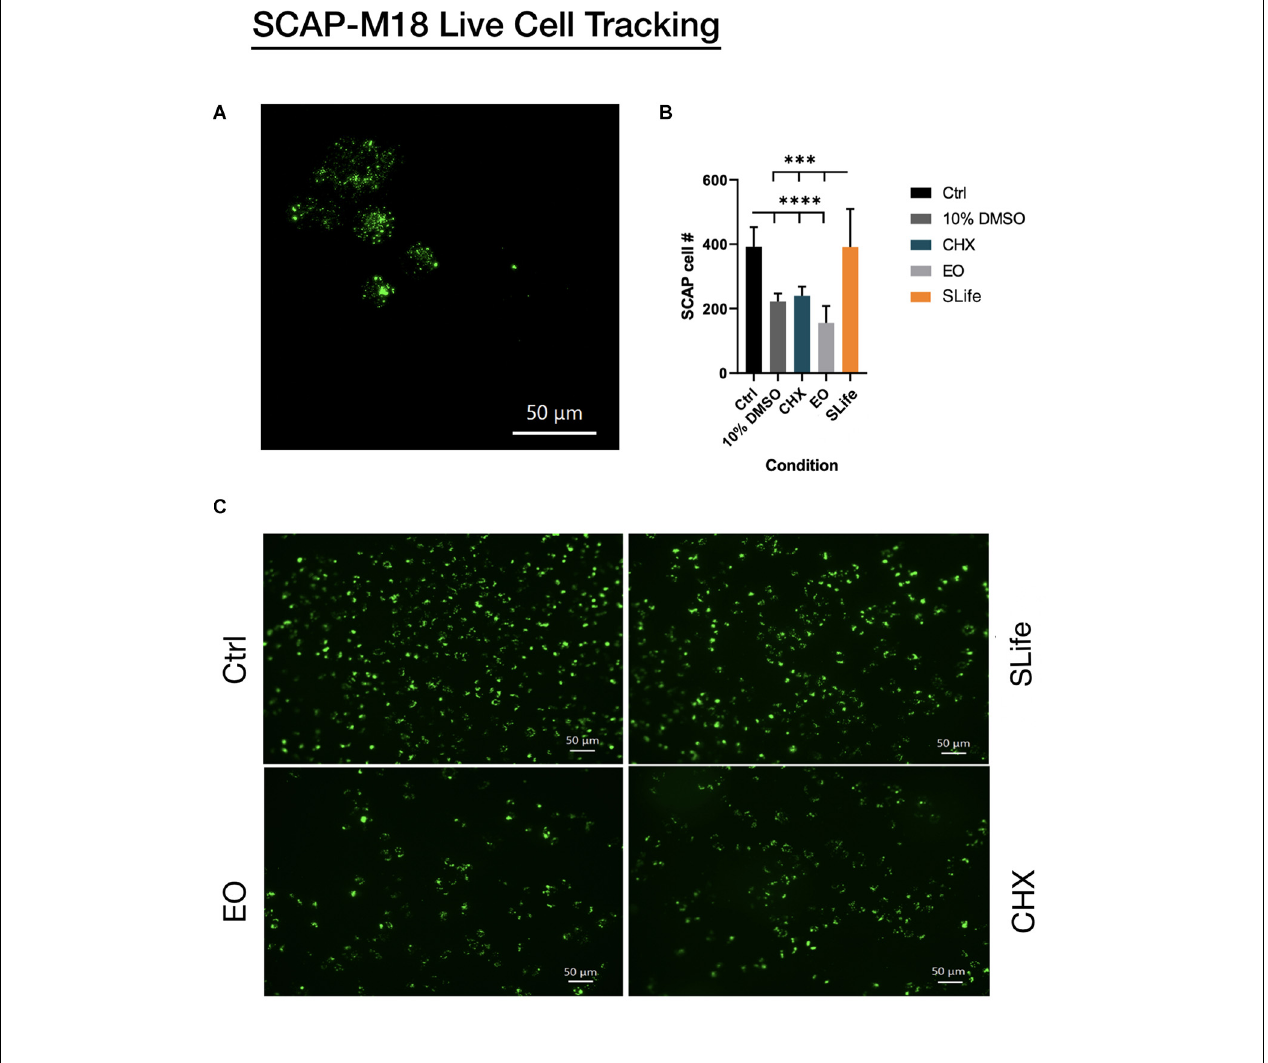
FIGURE 3 | Fluorescent nanocrystals were used to label stem cells of the apical papilla for live cell tracking. (A) SCAP cells loaded with nanocrystals can be seen at 40x magnification under fluorescence prior to challenge. (B,C) SCAP cells were stimulated with each of the oral solutions: PBS; SLife; EO and Chlorhexidine for 1 min, and then imaged by fluorescent microscopy (20x). (B) Lower asterisks in the bar chart represent significant differences between the control condition and selected conditions. Upper asterisks represent significant differences between the SLife group and selected conditions.